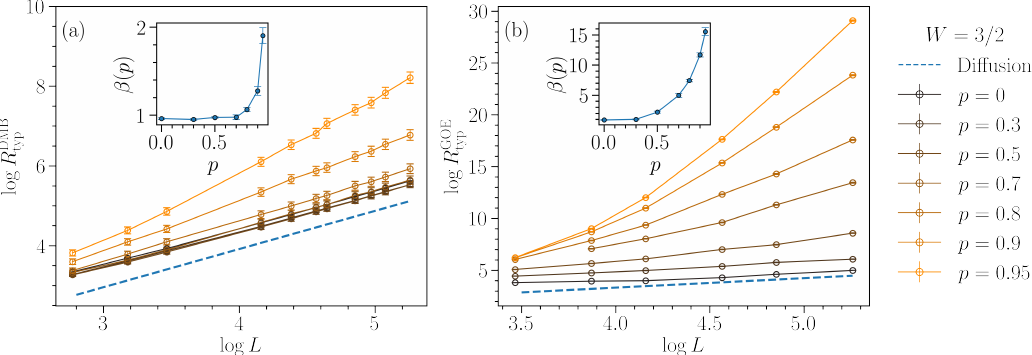
Figure 4: Typical resistance R (cfr. Eq. (15)) at W = 3 / 2 as a function of system size for typ the MDB (a) and GOE (b) Anderson models. Different curves correspond to different values of the dissipation probability p given in the key. The transport in both settings evolves from diffusive to subdiffusive when one disconnects more and more sites from the baths (i.e., by increasing p ). The blue dashed lines are the Ohm’s law (diffusion with β = 1). In the insets, we plot the associated exponent β ( p ) (cfr. Eq. (16)) extrapolated at different p . The fits are obtained by considering the largest system sizes (log L ≥